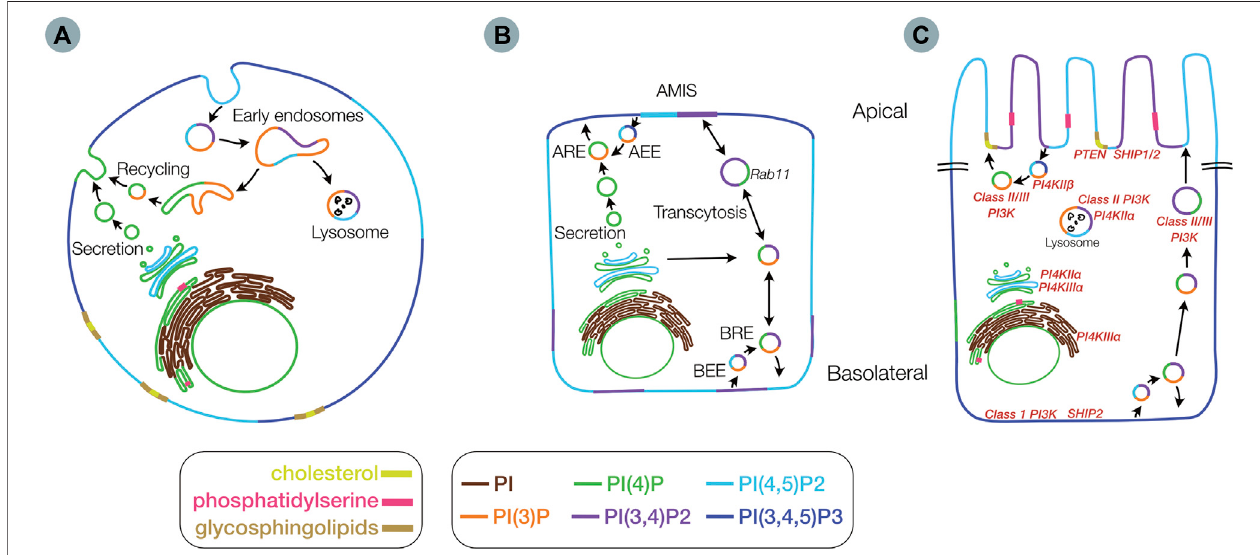
FIGURE3 | Membrane distribution oflipids involved inepithelial polarity. Membrane distribution ofphosphoinositides (PIs), phosphatidylserine, glycosphingolipids andcholesterolinanunpolarizedcell (A) ,inapartiallypolarizedcell (B) ,withanapicalmembraneinitiationsite(AMIS),andinafullypolarizedcell (C) includinglocationsfor key kinases and phosphatases (red) Inset legend indicates color scheme for lipid species (AEE) - Apical early endosome (ARE) - apical recycling endosome (BRE) - basolateral recycling endosome and (BEE) - basolateral early endosome.